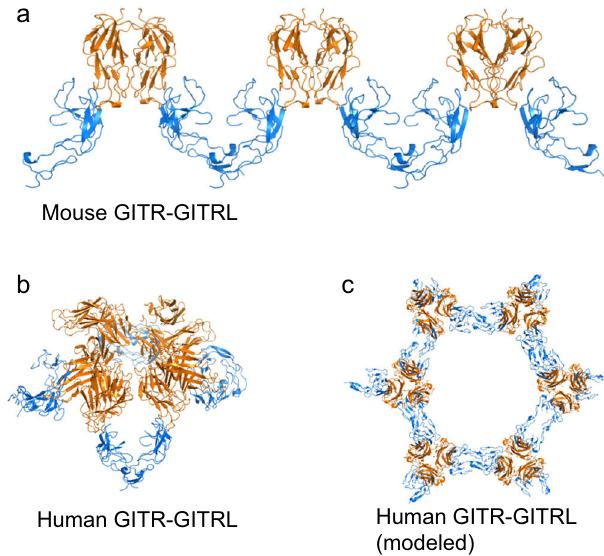
Fig. 5 Both human and mouse GITR can form higher-order structures.